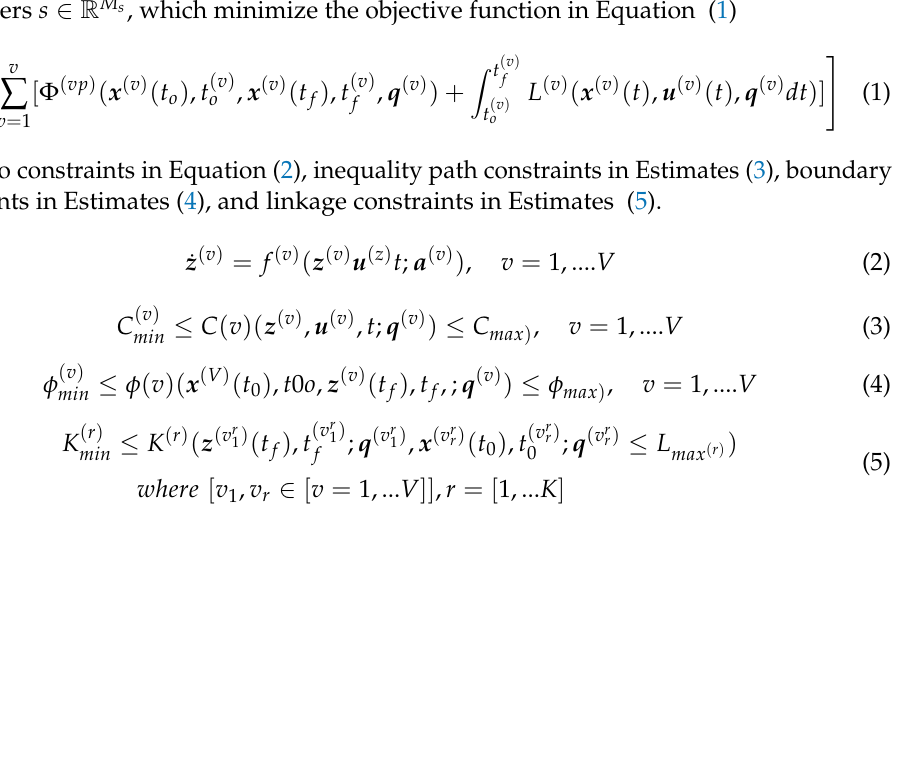
algorithm beginning with user-defined input data for the stated problem to the computation of the final